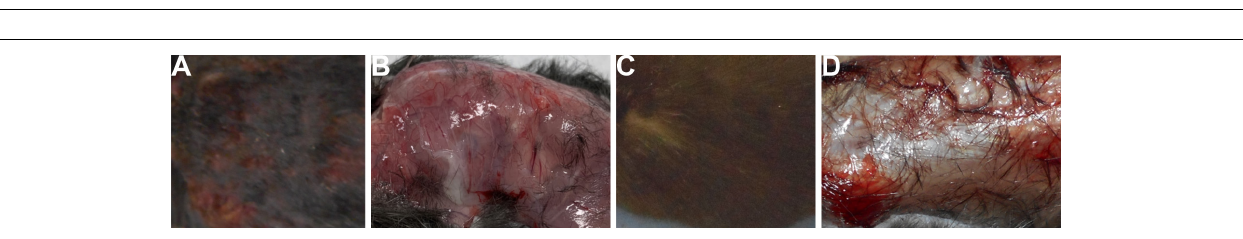
FIGURE 7 | (A–G) Macroscopy and histological analysis of animals following problems linked to the waterproofness of the device. (A) Severe inflammation observed in tissue (muscle of the back) in contact with the device. (B,C) Hematoxylin-eosin staining of skin section. Muscular degeneration is observed, indicating tissue damage (arrowhead). (D) Splenomegaly observed in animals showing an infection. (E–G) Tests for the confinement of cell chambers/device. (E) No leakage was observed with this cell chamber. (F) Bacteria were detected in plates, indicating poor waterproofing of the cell chamber. (G) The presence of cells and scaffold in a Petri dish, indicating incorrect waterproofing of the cell